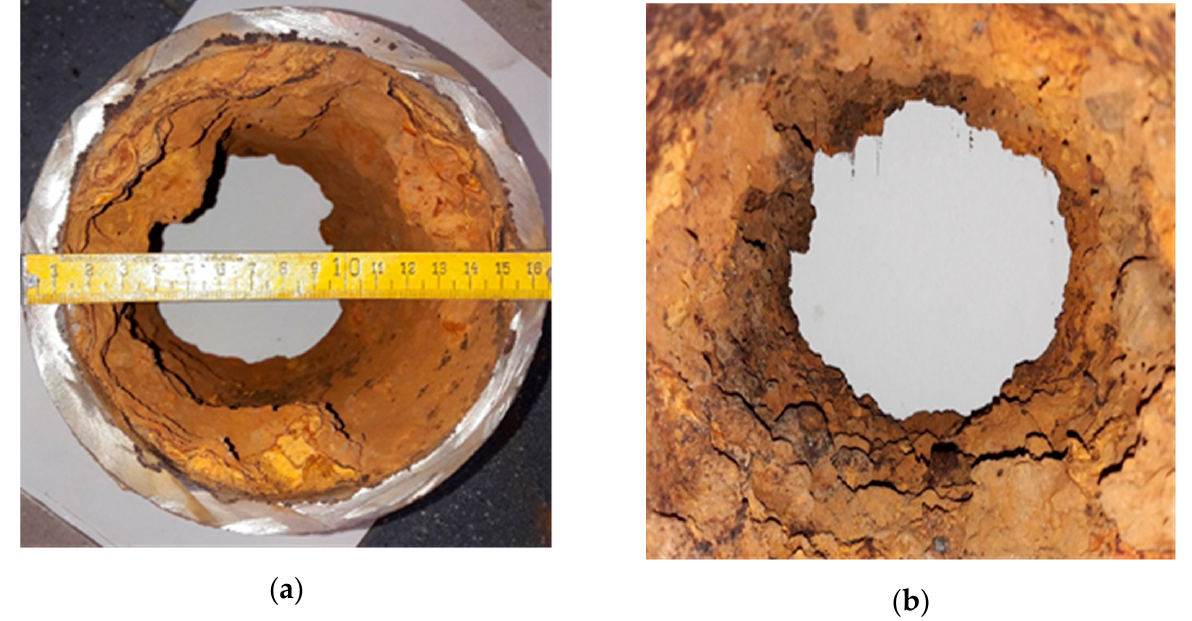
Figure 1. Cast-iron pipe after 30 years of exploitation: ( a ) Pipe cross section; ( b ) Sediments accumulated during the pipe exploitation.